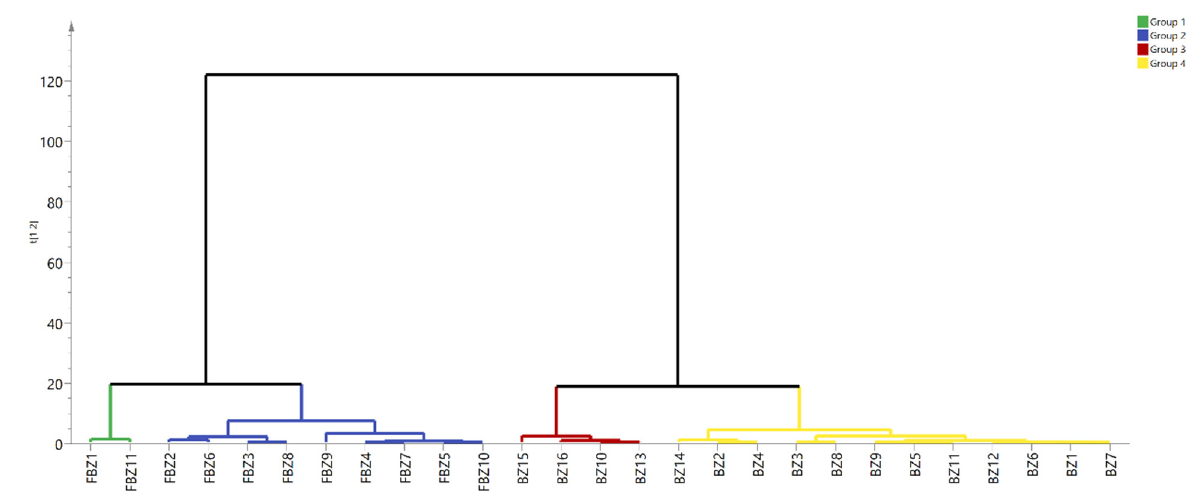
Figure 3. PCA dendrogram of 27 batches of samples.